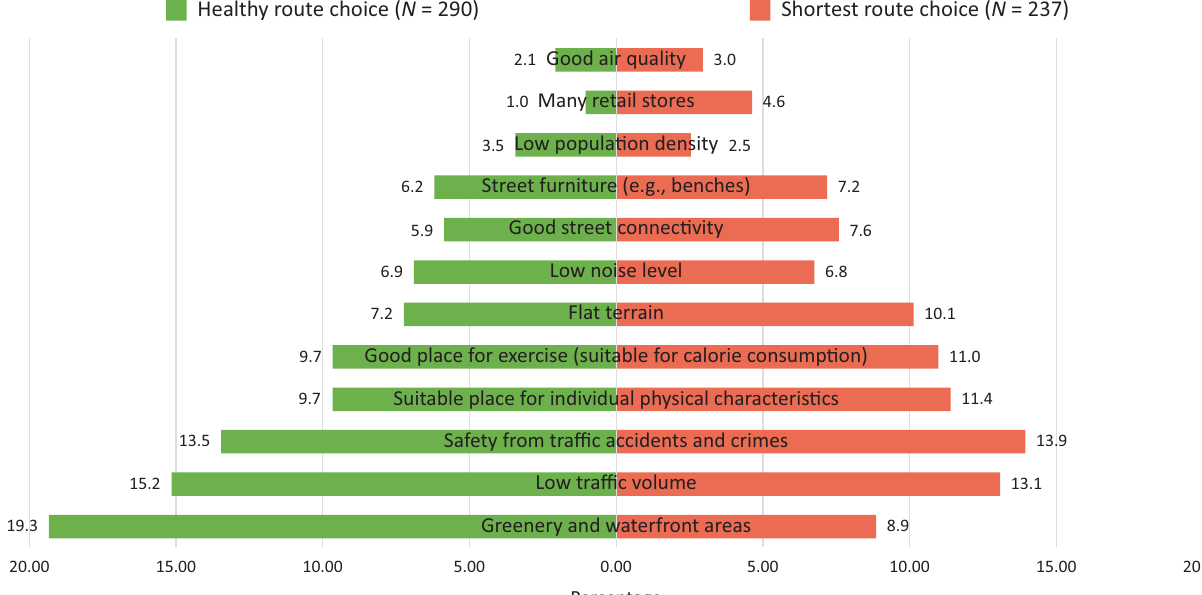
Figure 3. Preferred environmental factors in pedestrian navigation mobile application of the subsamples (the shortest route group vs. healthy route